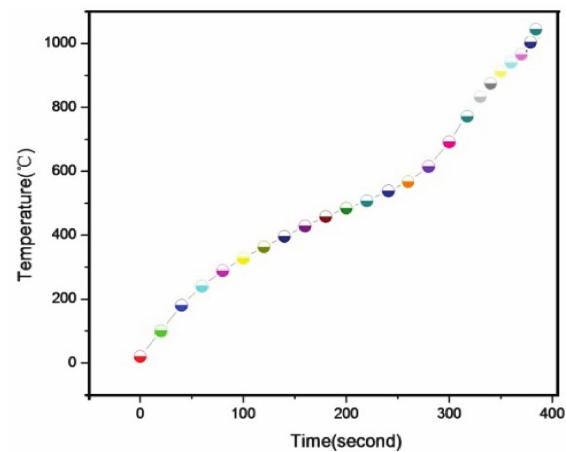
Figure 3: The temperature rising curve of chromium powder heating in the 2.45GHz microwave